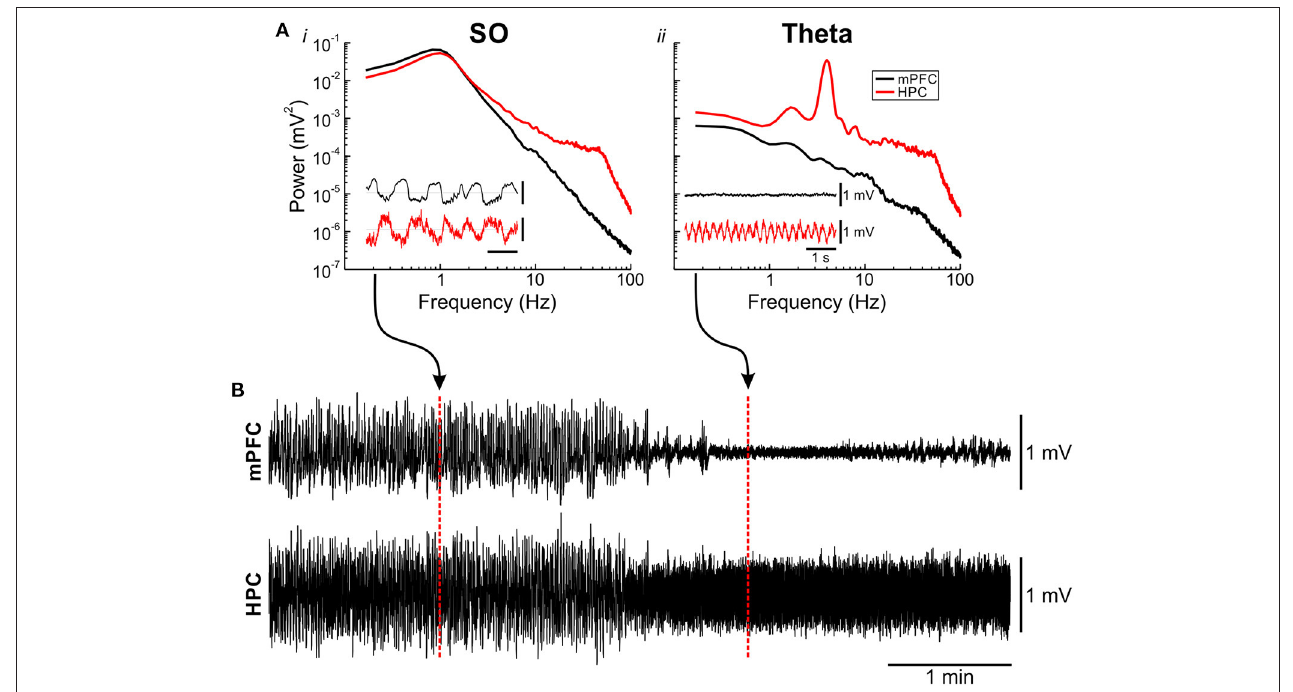
FIGURE 2 | Urethane-anesthetized animals display spontaneous alternations of forebrain state. (A) Power spectra and raw local field traces (inset) of the slow oscillation (SO) [deactivated; (Ai) ] and theta [activated; (Aii) ] states observed under urethane anesthesia. During the SO state (Ai) , large-amplitude ∼ 1Hz fluctuations can be seen in the medial prefrontal cortex (mPFC) (black) and hippocampus (HPC) (red) field, with spectral power maxima at both sites at ∼ 1Hz. During the theta state (Aii) , low voltage, fast activity is apparent in mPFC (black) with a prominent ∼ 4Hz theta rhythm obvious in the HPC (red), which is also reflected in the power spectrum. ( B) Continuous local field traces of a spontaneous transition from a deactivated (SO) to an activated (theta) state. Positions from where the inset exemplar traces were taken from are highlighted with dashed red